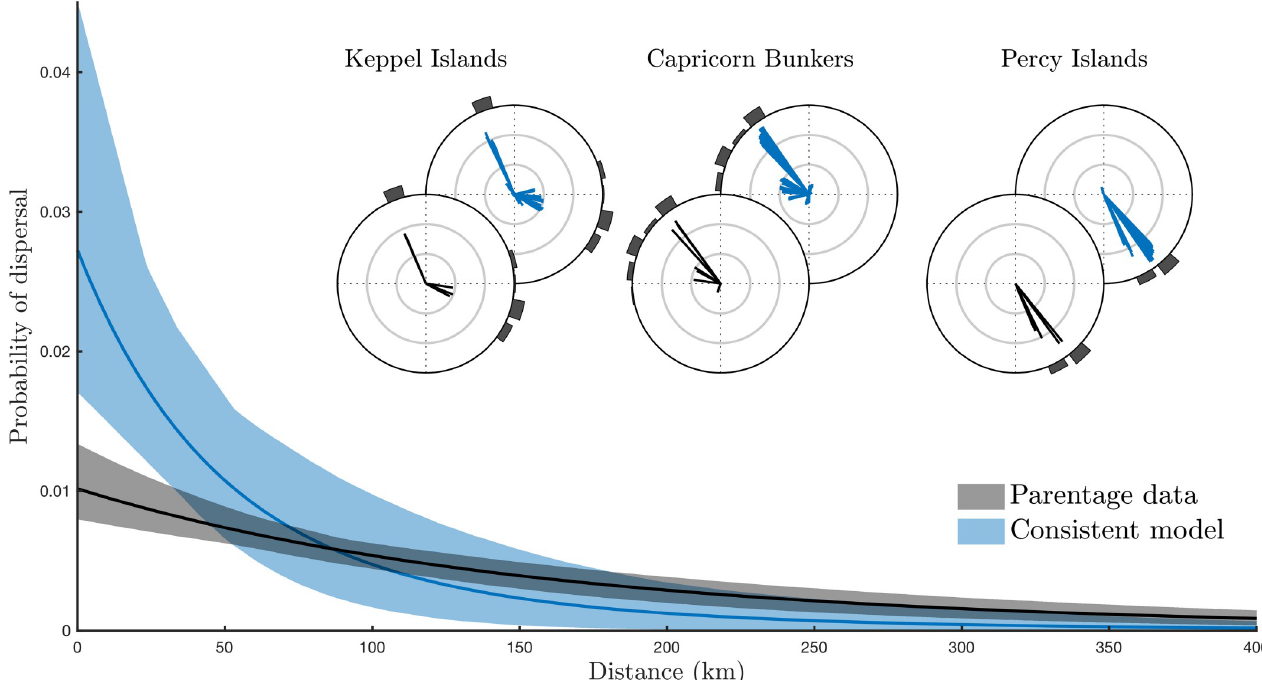
Fig 3. Scale and direction of dispersal. Dispersal kernels indicating the scale of dispersal observed in the dataset of parentage assignments (grey) and the consistent model simulations (blue). Shaded regions indicate 95% confidence bounds of uncertainty, resulting from sampling variation (adults and juveniles) and uncertain adult population size. The consistent model predicts a larger proportion of short-distance dispersal—and consequently, less long-distance dispersal—than the genetic parentage data. Inset: compass plots illustrating the straight-line direction and distance travelled from each reef group by all larvae in the parentage dataset (black) and in the consistent model (blue). Concentric circles measure distances of 100 km, 200 km, and 300 km (outside circle). Histograms indicate the relative availability of sampled habitat in each direction in the other two regions. The data used in this figure are given in S1 Data.